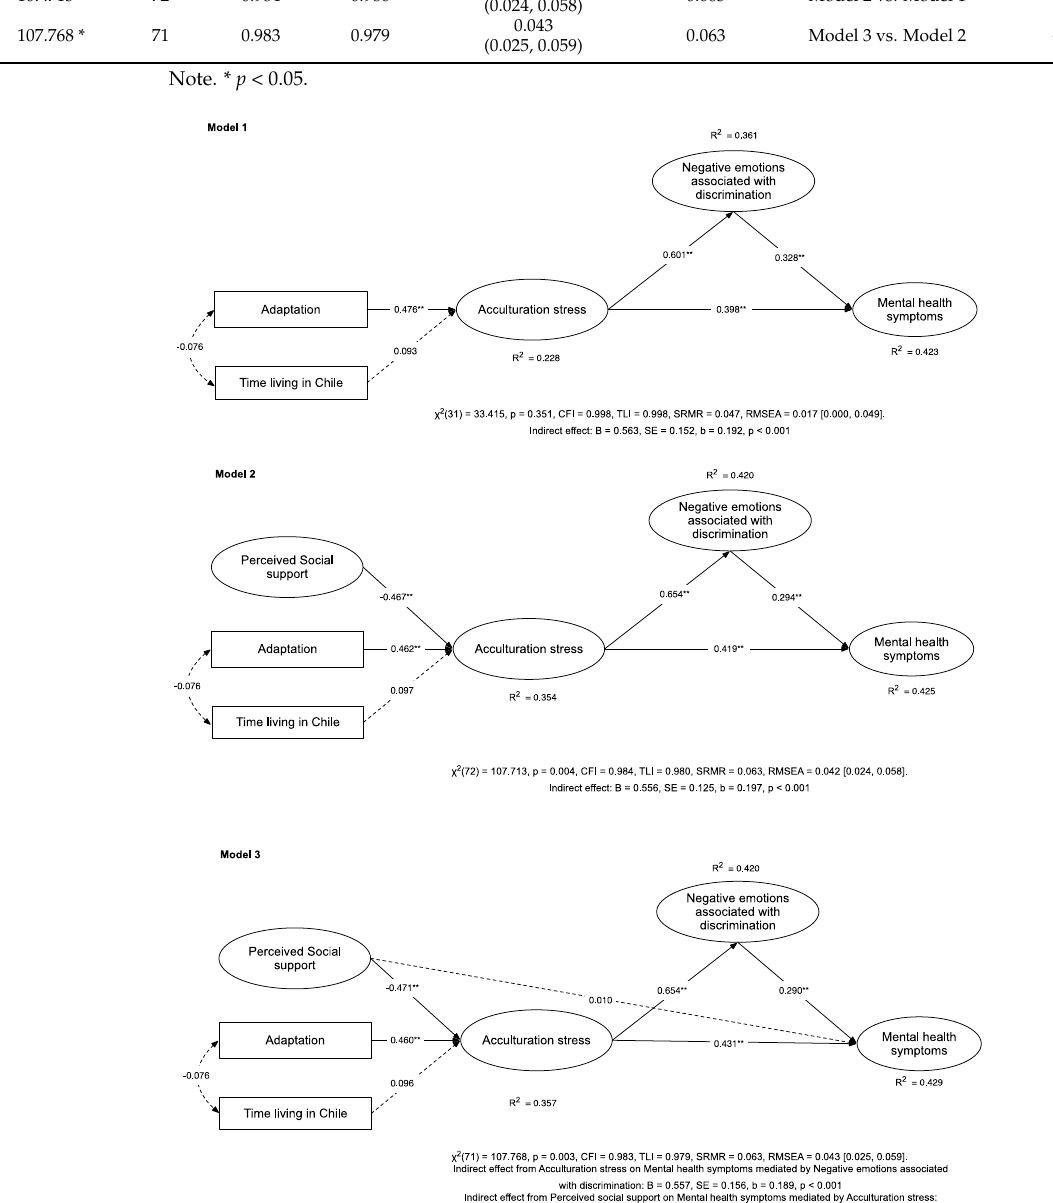
Figure 2. Models tested: 1, 2, and 3. * p < 0.05; ** p < 0.001.